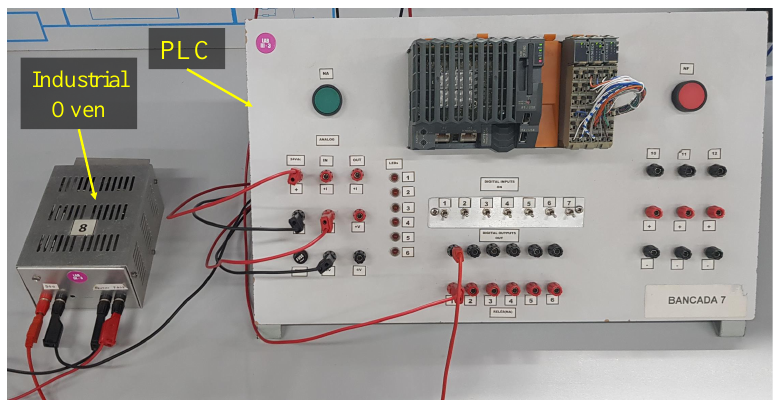
Figure 7. Photograph of the PLC and industrial oven employed for comparison